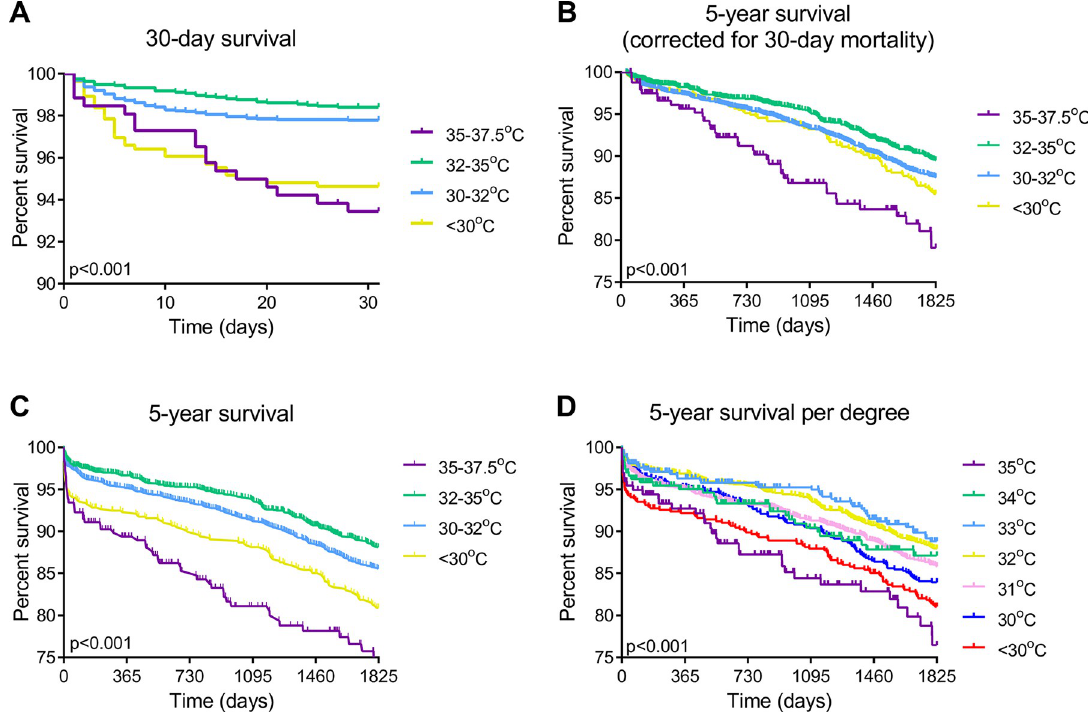
Fig 3. Survival per minimal nasopharyngeal temperature. (a) 30-day survival, (b) 5-year survival corrected for 30-day survival (31 days– 5 year), (c) 5-year survival and (d) 5-year survival per degree.